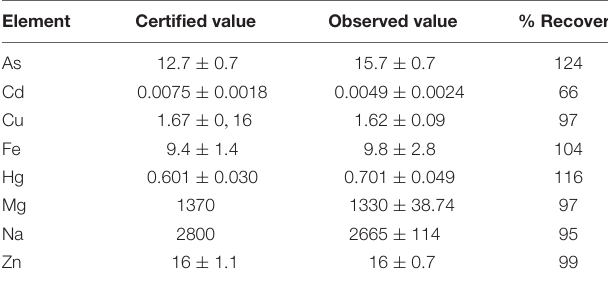
using the following equations: LOQ = (3 × DSDP × df)/slope of the line